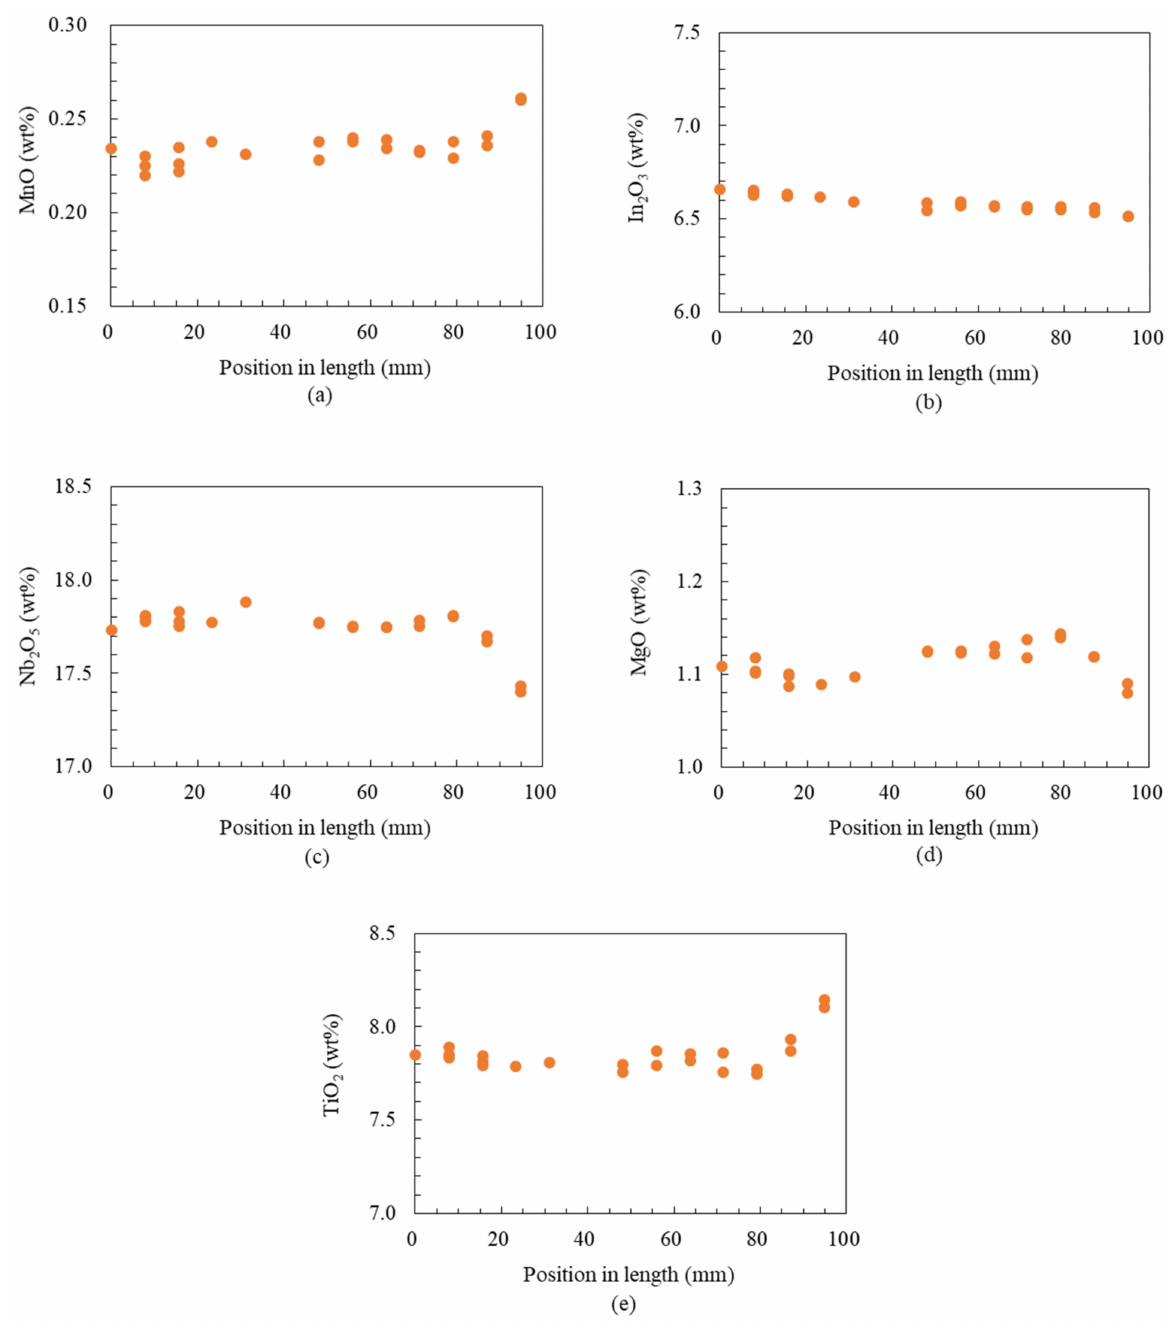
Figure 3. Distributions of ( a ) MnO content, ( b ) In 2 O 3 content, ( c ) Nb 2 O 5 content, ( d ) MgO content, and ( e ) TiO 2 content for the Mn:PIN-PMN-PT boule along growth direction. The ranges in the electromechanical coupling coefficient k 33 and the piezoelectric coefficient d 33 in the stable property region of the Mn:PIN-PMN-PT boule were 0.931–0.934 and 1352–1517 pC/N, respectively. The ranges were slightly lower than those of the non- doped PIN-PMN-PT boule. Therefore, the Mn doping made a negative contribution to piezoelectric